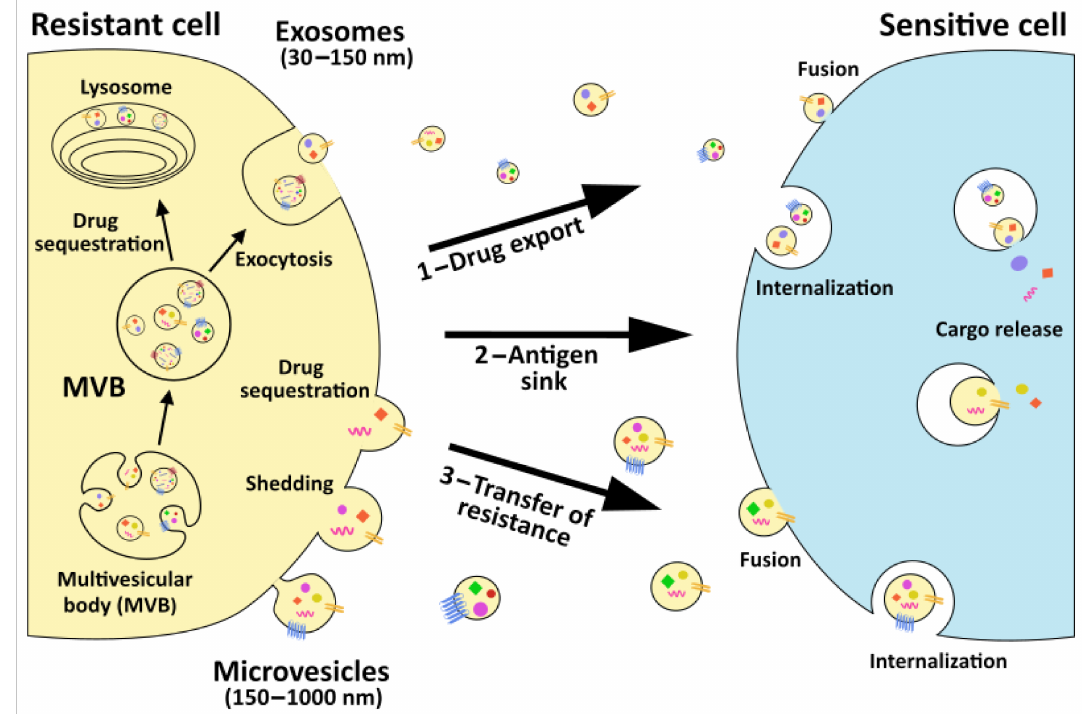
Figure 1. Graphical representation of extracellular vesicle (EV) roles in cancer drug resistance. Both microvesicles and exosomes can facilitate drug sequestration by directly loading and exporting anti-tumor agents from cancer cells (step 1) or by binding on their surface therapeutic antibodies in the extracellular space (step 2). Once released, EVs can also be taken up by recipient cells and release their cargo. Cargo release can affect recipient cell phenotype, modifying their sensitivity to specific drugs (step